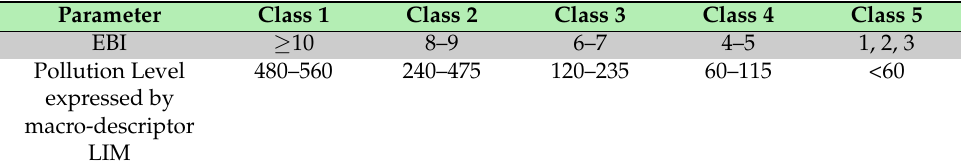
Table A2. Determination of ecological status by the extended biotic index (EBI) and LIM.